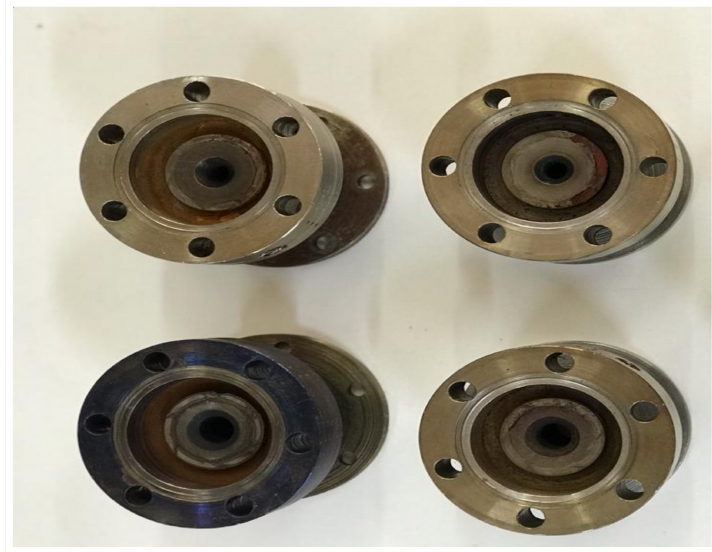
Figure 6. Four anodes with various dimensions and cross sections.